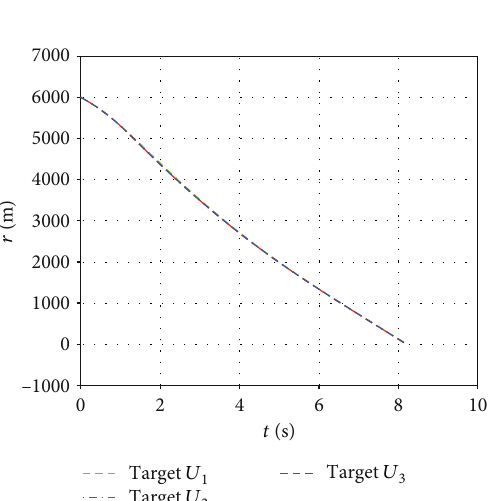
Figure 12: Ranges between the missile and the